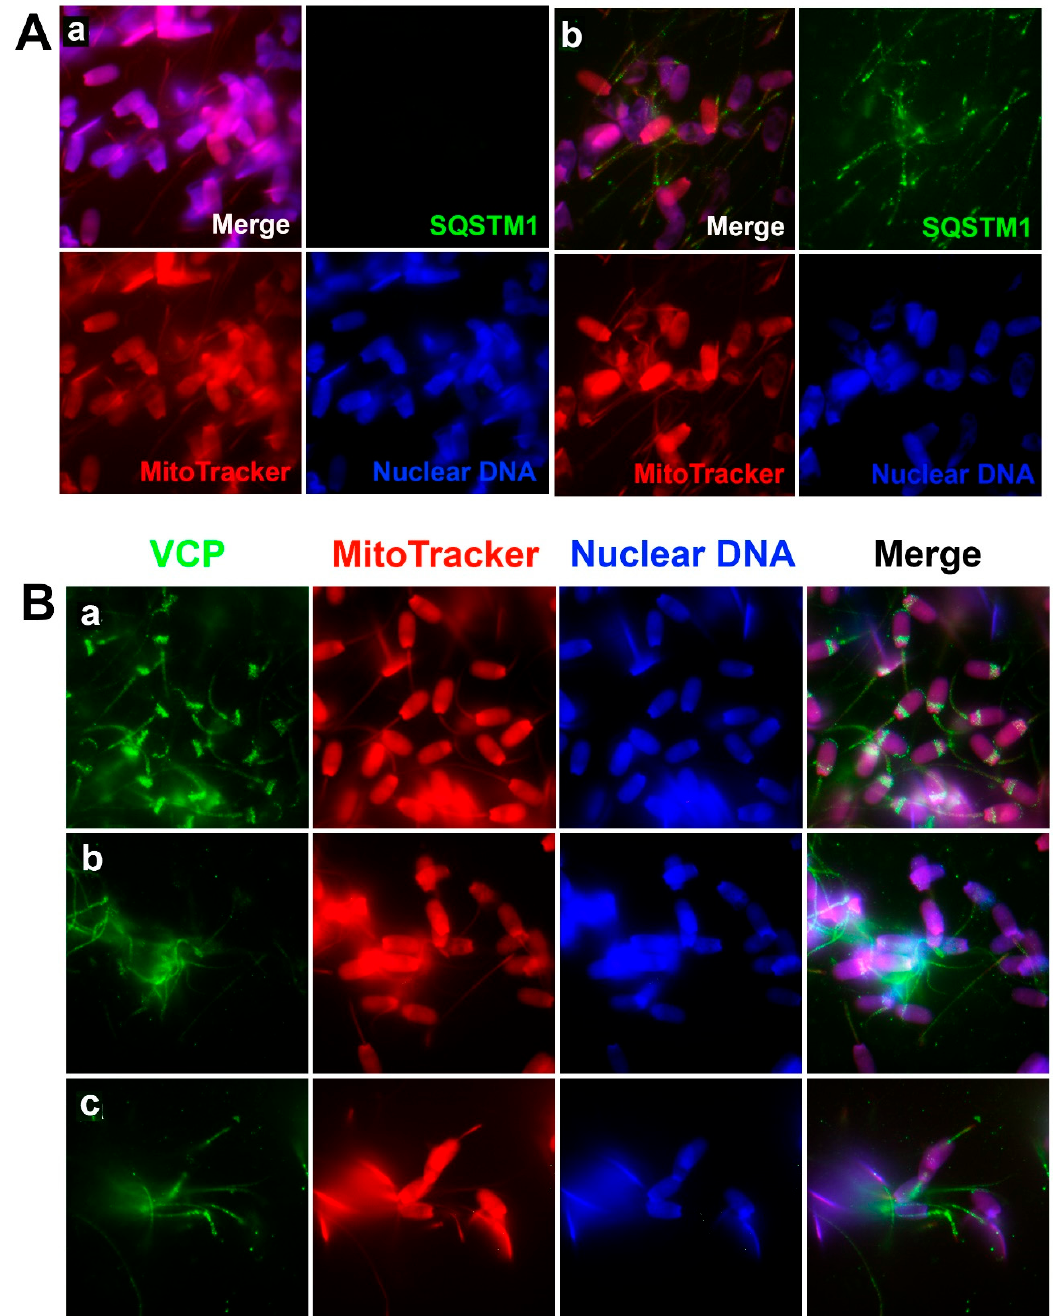
Figure 2. Binding of mitophagy factors SQSTM1 and VCP to sperm mitochondria in the porcine cell-free system. Spermatozoa pre-labeled with MitoTracker were primed with 0.05% lysolecithin and 10 mM DTT, then co-incubated for 4 h with porcine oocyte extracts or with an oocyte extraction buffer (no oocyte extract) as a control, fixed and immunolabeled with anti-SQSTM1 ( A ) or anti-VCP antibodies ( B ). SQSTM1 was not detected in spermatozoa exposed solely to the extraction buffer ( Aa ), but SQSTM1 was detected in the midpiece/mitochondrial sheaths of sperm after co-incubation in oocyte extract ( Ab ). VCP was detected in spermatozoa that were not exposed to the lysolecithin or DTT treatment and were exposed to extraction buffer (no oocyte extract); these spermatozoa acted as a control ( Ba ). Likewise, VCP was detected in spermatozoa that were then exposed to the lysolecithin and DTT priming process and co-incubated for 4 h with extraction buffer (no oocyte extract) ( Bb ) and also oocyte extract ( Bc ). The VCP protein was prominent in the sperm mitochondrial sheath both before ( Bb ) and after ( Bc ) co-incubation, while the control spermatozoa without treatment of DTT and oocyte extracts also displayed VCP in postacrosomal sheaths and the subacrosomal layer of the sperm head ( Ba ). Original magnification: 1000 ×